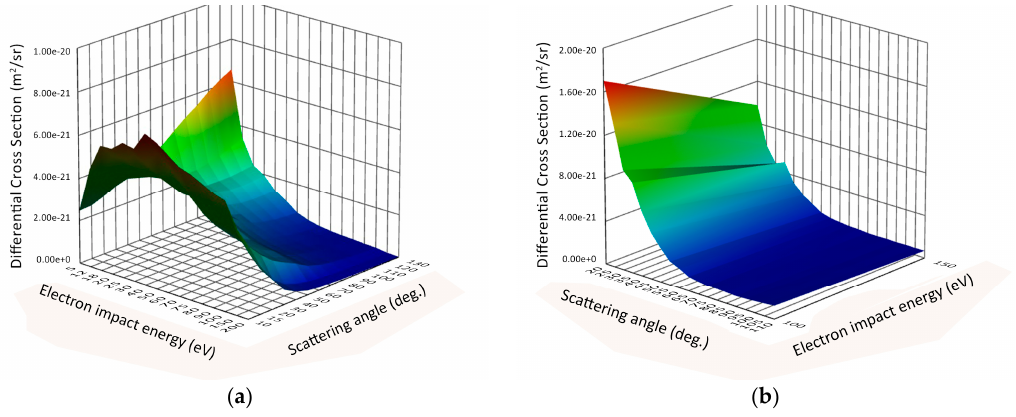
Figure 3. DCS surfaces as retrieved from RADAM database [29] for elastic electron scattering by: ( a ) He atom—data points are taken from ref. [30]; ( b ) Formamide molecule—data points are taken from ref. [31].